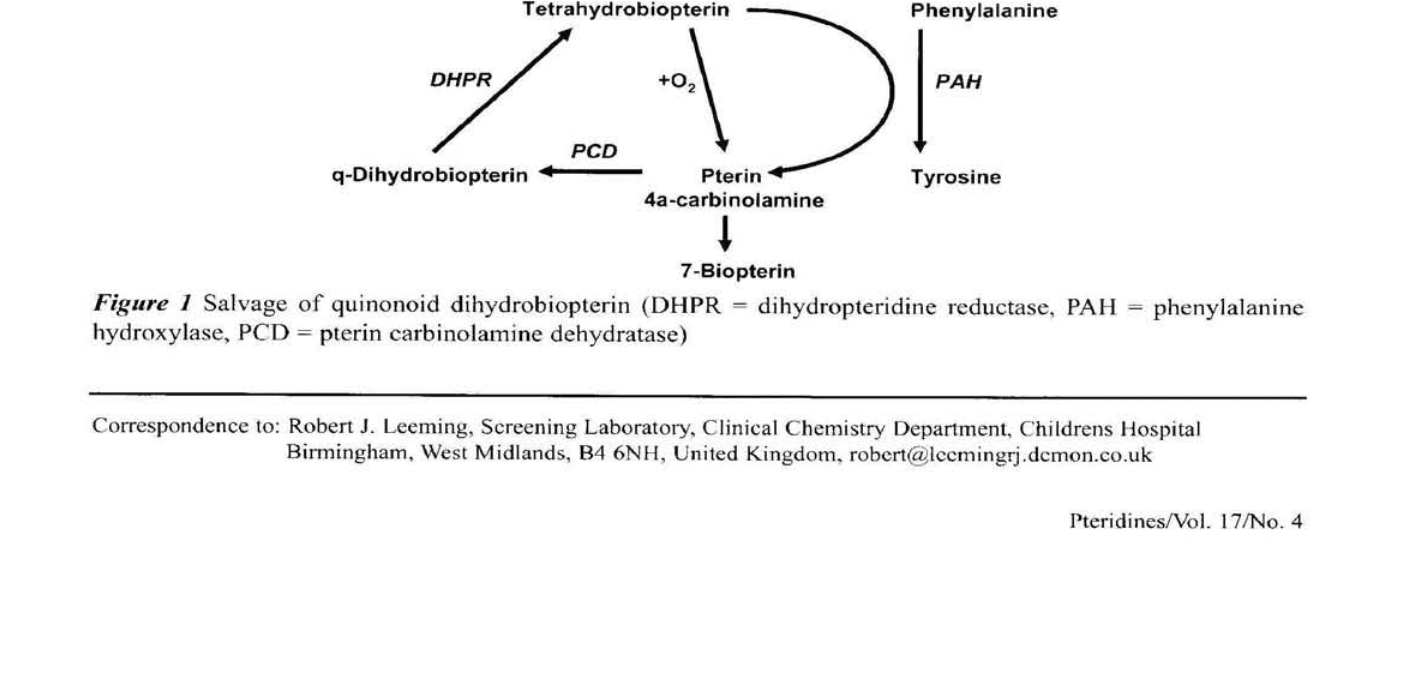
Figure 1 Salvage of quinonoid dihydrobiopterin (DHPR = dihydropteridine reductase, PAH - phenylalanine hydroxylase, PCD = pterin carbinolamine